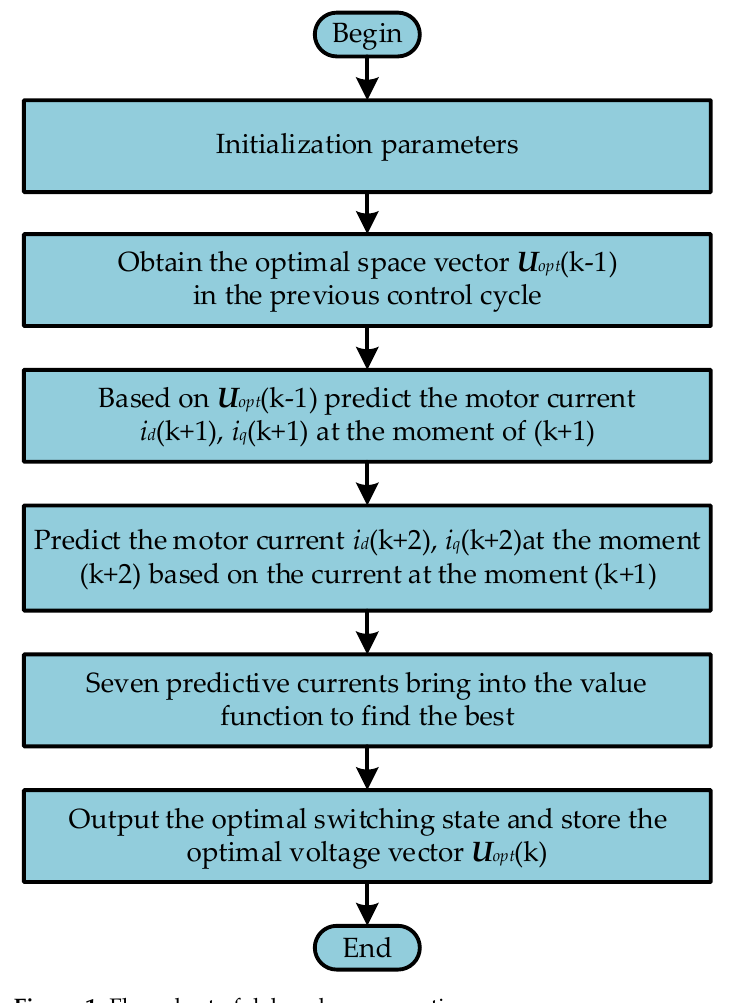
Figure 1. Flow chart of delayed compensation.